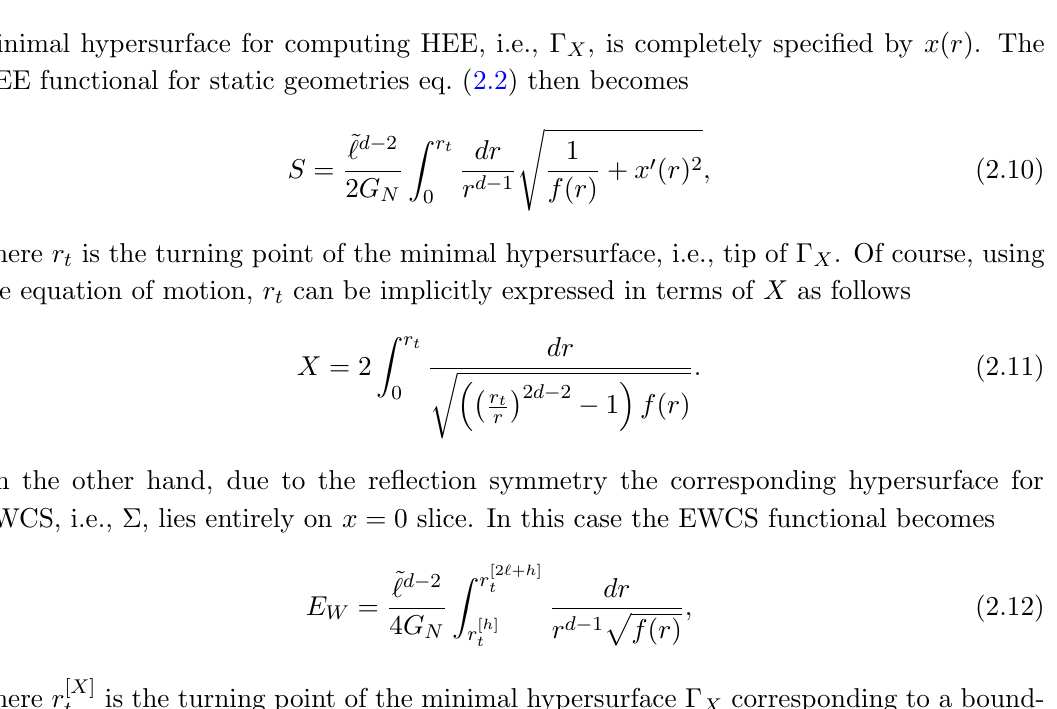
Figure 1 . Schematic minimal surfaces for computing S (middle) con(cid:12)gurations. In the right panel, we show the EWCS ((cid:6) in orange). Here we only consider the connected con(cid:12)guration where the EWCS is